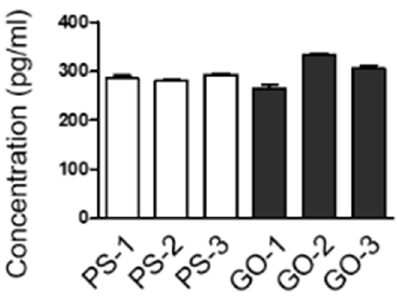
Figure 12. Secretion of a cytokine. The concentration of secreted VEGF from PS or GO substrates- cultured hBM-MSCs did not appear to have a significant difference.